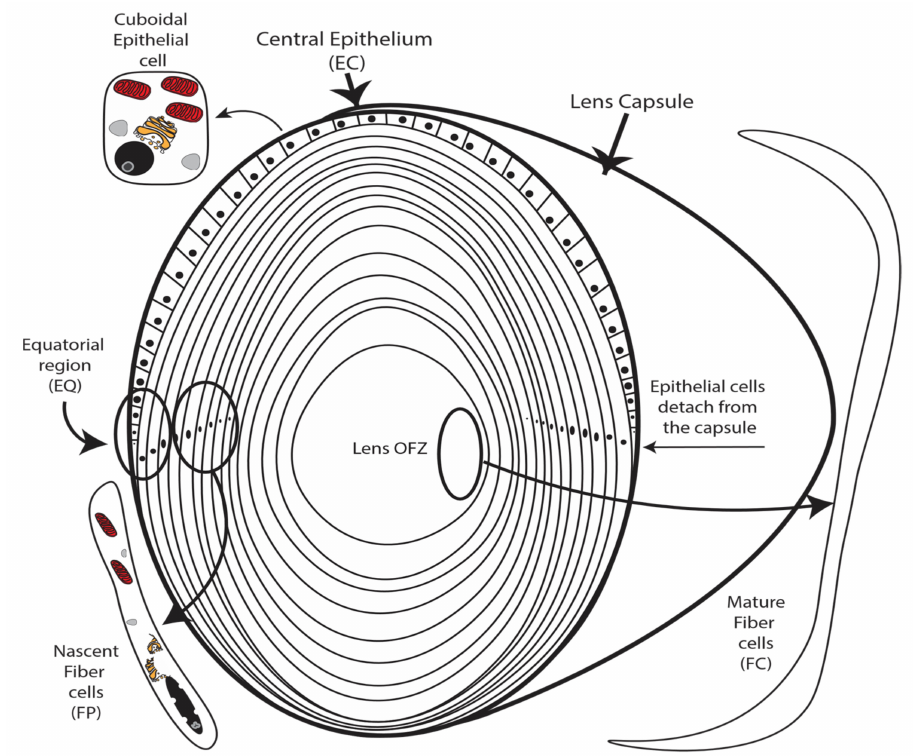
Figure 1. The lens is composed of a layer of undifferentiated epithelial cells that overlie a core of elongated fully differentiated organelle-free transparent fiber cells. The process of lens differentiation is characterized by the dissociation of epithelial cells from the lens capsule (indicated), elimination of all cellular organelles (indicated), and elongation to the form the core of fully differentiated fiber cells forming the core lens organelle-free zone (OFZ) (indicated). Degradation of organelles is a hallmark feature of lens cell differentiation (indicated). Lens fiber cell nuclei condense before degradation